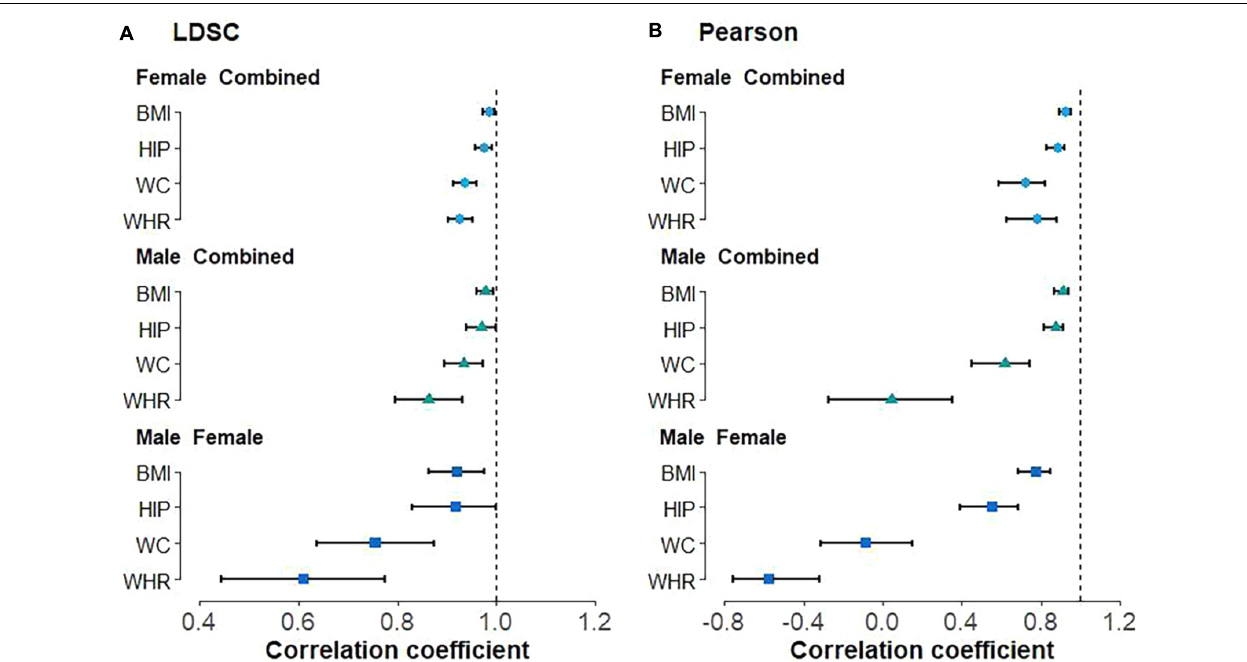
FIGURE 1 | Genetic correlation between sex-combined and sex-specific anthropometric traits as well as between male-specific and female-specific anthropometric traits using (A) linkage disequilibrium score regression (LDSC) and (B) Pearson’s correlation analyses. BMI, body mass index; WHR, waist-to-hip ratio; WC, waist circumference; HIP, hip